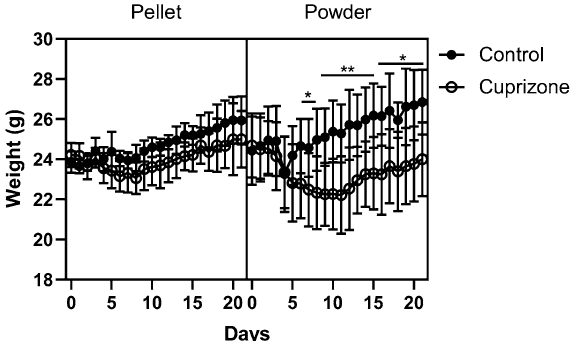
Figure 1. Effects of cuprizone feed formulation on animal weights. Animals were weighed daily to assess weight loss throughout cuprizone administration. Cuprizone was delivered in either pelleted or powdered form. N = 6 mice per group; graph displays mean weight ± SEM. Significant differences are indicated by *p ≤ 0.05, **p ≤ 0.01.